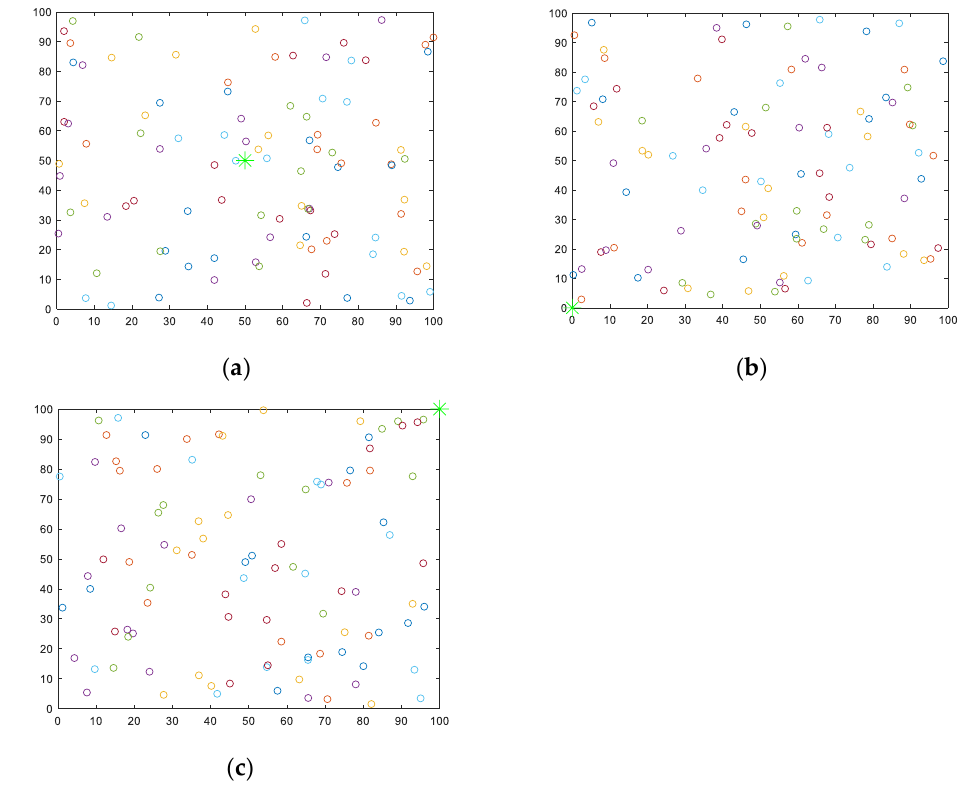
Figure 2. Distribution of the network elements (BS, CHs, and SNs) in the network area. ( a ) Sensor BS Location (0,0). ( b ) Sensor BS Location (50,50). ( c ) Sensor BS Location (100,100).